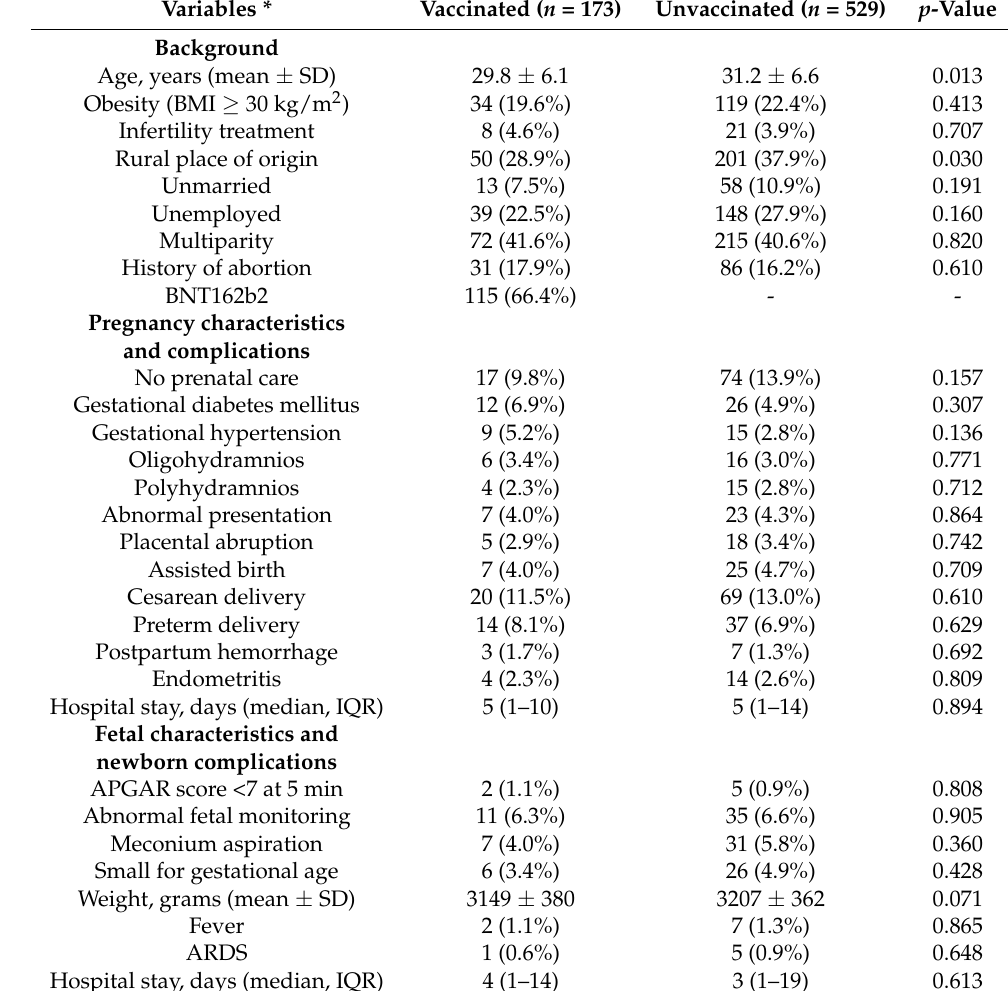
Table 1. Comparison between vaccinated and unvaccinated pregnant women without COVID-19 history.